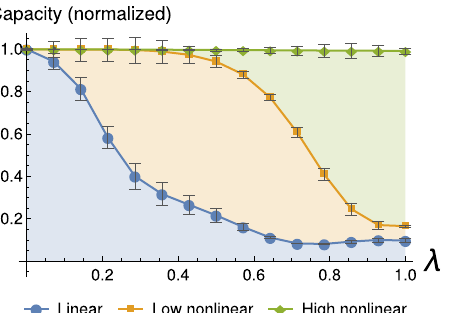
Fig. 4 Histogram bars showing the information processing capacity for different input encodings. The capacities are further divided into linear (degree 0 or 1) and nonlinear contributions (degree 2 or higher), where the degree is given by the functions that the reservoir can reconstruct. Capacity of an echo-state network (ESN) with as many neurons (8) as there are oscillators in the harmonic network is shown for comparison. The output is a function of reservoir fi rst moments when encoding to either magnitude ∣ α ∣ or phase arg ð α Þ of displacement. Three different ways to encode the input in the limit ∣ α ∣ → 0 are shown; for them the output is a function of the elements of reservoir covariances, with the input being encoded either to thermal excitations n th , squeezing strength r or angle φ